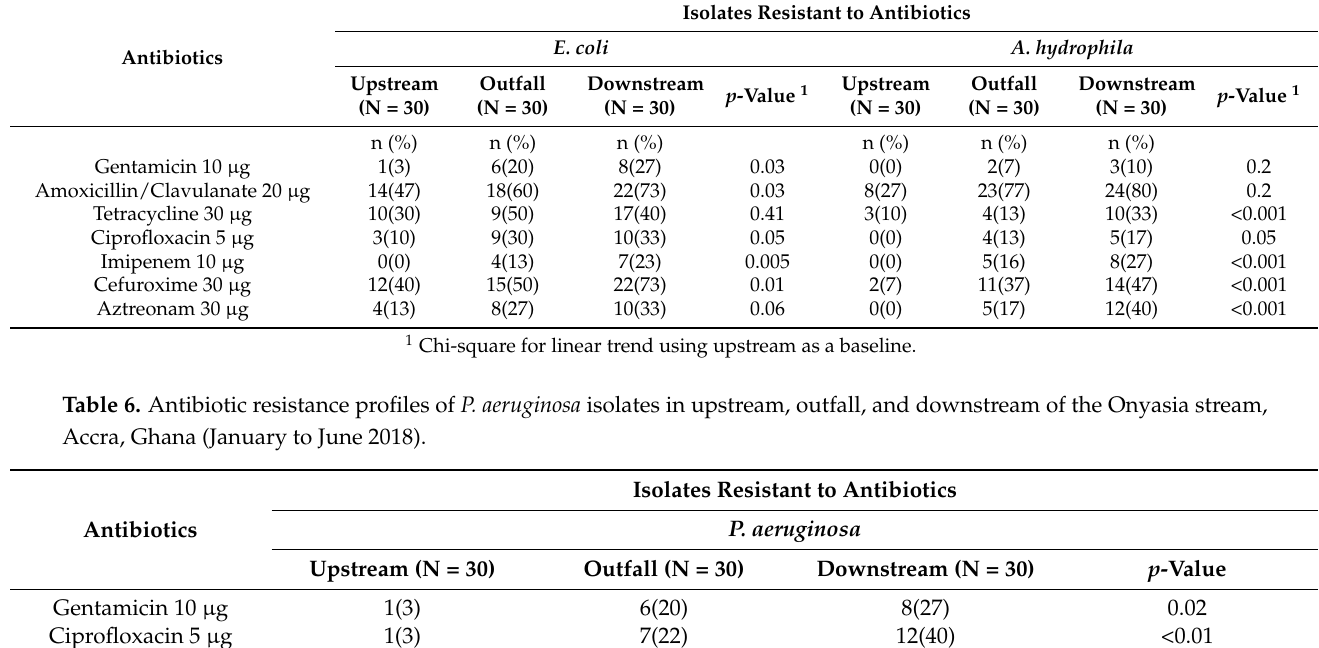
Table 5. Antibiotic resistance profiles of E. coli and A. hydrophila isolates in upstream, sewage outfall, and downstream of the Onyasia stream, Accra, Ghana (January to June 2018). Isolates Resistant to Antibiotics E. coli A. hydrophila Antibiotics Upstream (N = 30)